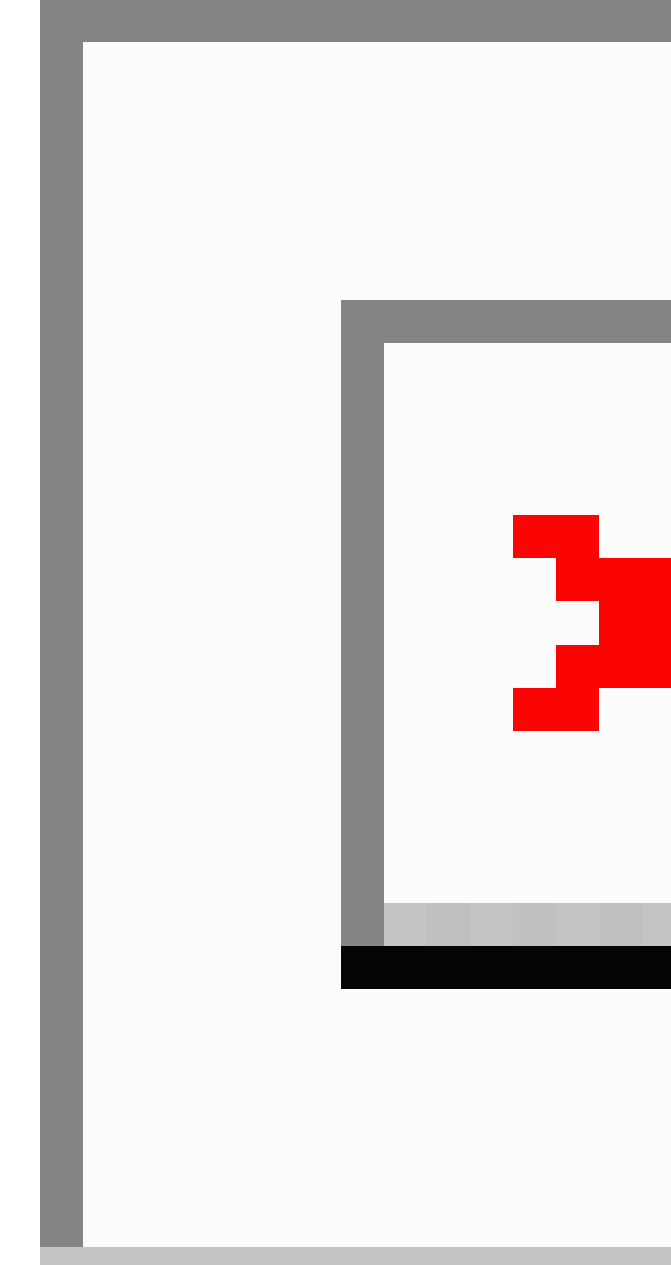
DHSNs rank distribution, X-Y scatter plots were created in Microsoft Excel (Figure